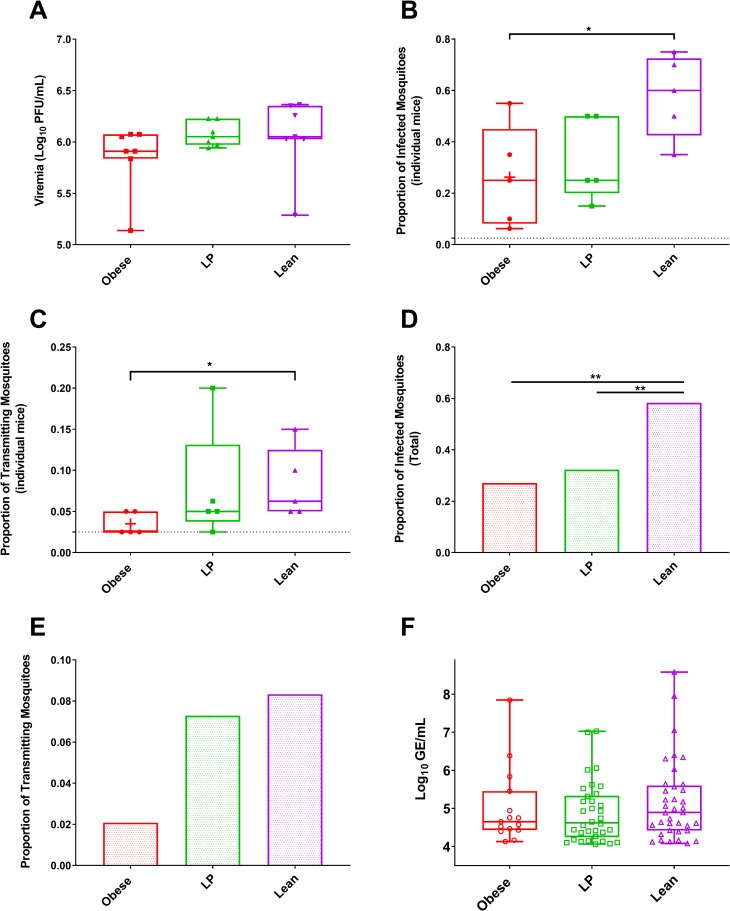
Virus from obese mice decreased infectivity to mosquitoes and lower transmission rates.Groups of C57BL/6N mice (7 mice per group) were fed either a 45% fat (Obese), 5% protein (LP), or control (Lean) diet for 8–10 weeks. Mice were then infected with Mayaro virus (MAYV), and two days later were individually used to feed groups of Aedes aegypti mosquitoes. Serum was also collected to measure viremia two days post-infection by plaque assay (A). Mosquitoes were dissected ten days post-feeding on the viremic mice, at which point bodies (for infection, B and D) and saliva (for transmission potential, C and E-F) were collected for individual mosquitoes. The infection and transmission rates were calculated for the mice individually within a group (B-C) and for all individual mice combined within a group (D-E) based on the presence or absence of infectious virus tested by plaque assay. The number of RNA copies were calculated by qRT-PCR (F). The whiskers represent the minimum and maximum points, the box limits represent the 25th and 75th percentile, and the horizontal line represents the median. Statistical analyses for A-C and F were performed by one-way ANOVA with Dunnett’s correction compared to the control group. For comparing rates in D and E, a two-tailed Fisher’s exact test was used. The level of significance is represented as follows—* p<0.05, ** p<0.01.